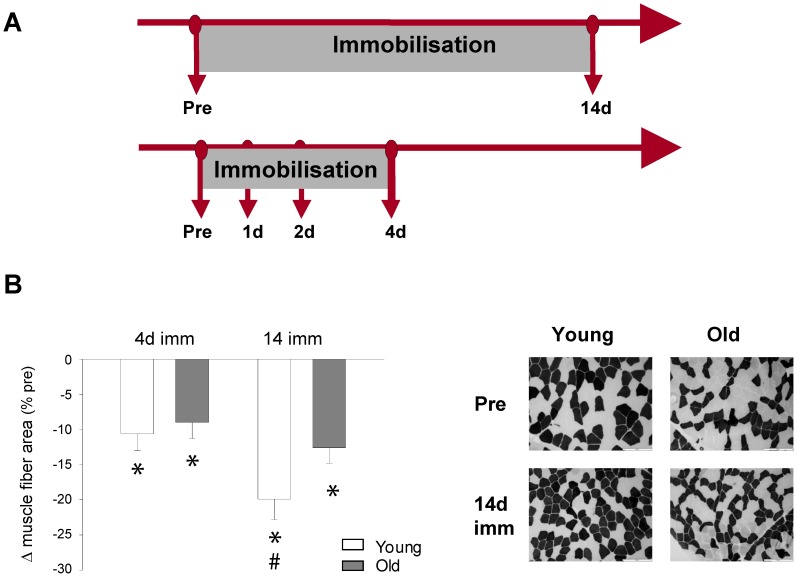
Immobility-induced skeletal muscle atrophy causes an age-specific decline in muscle size.
A. Scheme of experimental setup, including the time points of muscle biopsy procedure. B. Percentage decreases in muscle size (mean muscle fiber area) after 4 days of immobility in young (n = 11) and old (n = 9) as well as after 14 days of immobilization in young (n = 11) and old (n = 12), respectively. * Time effect, p<0.05 compared to pre, # Age effect, p<0.05 young compared to old within time point. Group mean data ± SEM. Mean myofiber area was assessed in the quadriceps femoris muscle, by muscle biopsy sampling. C. Muscle histology from resting state (pre) and immobility (14 d) was analyzed by myofibrillar ATPase at pH 10.3 preincubations demonstrating type I (white) and type II muscle fibers (black) [52].